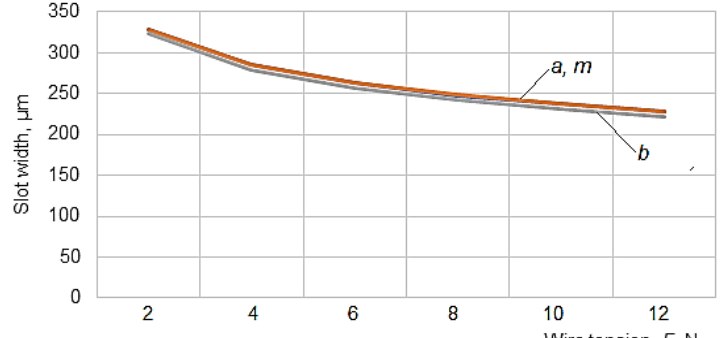
Figure 8. Influence of the wire tension F on the width of the slot when the wire electrode enters the test sample ( a ), in the middle of the thickness of the test sample ( m ), and at the exit of the wire electrode from the test sample ( b ) ( H = 20 mm, T on = 12 µs, T off = 30 µs, I = 3.1 A, F = 10.54 N, v = 2500 mm/min).